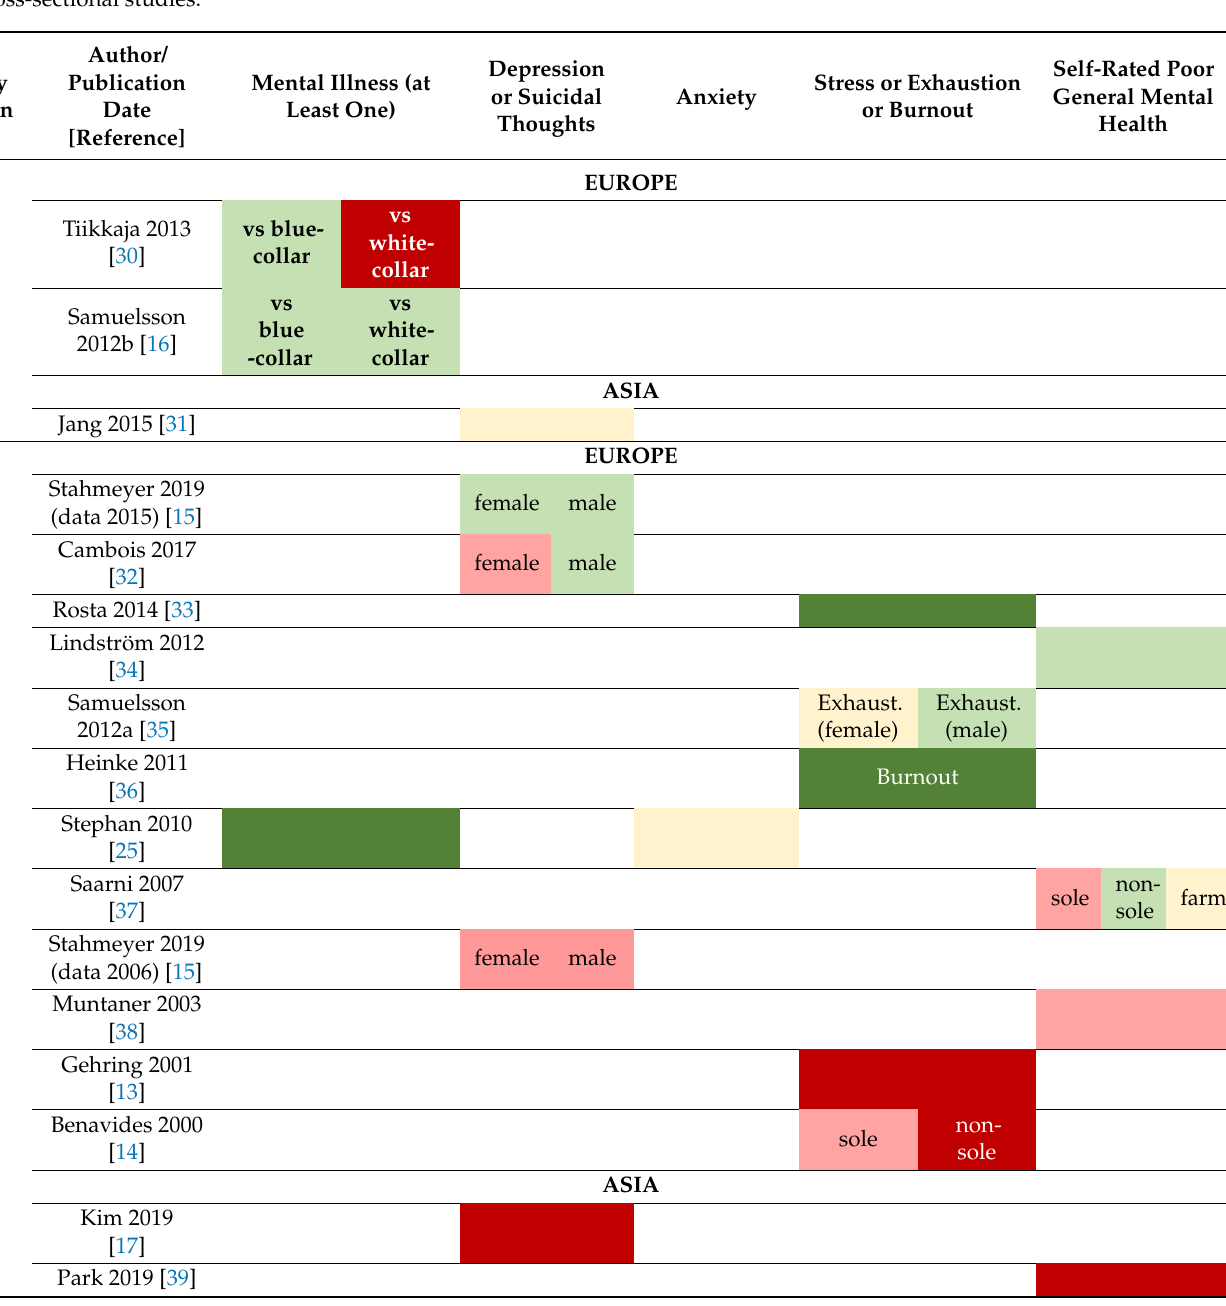
Table 4. Overview of mental health outcomes among self-employed compared to employed persons in longitudinal and cross-sectional